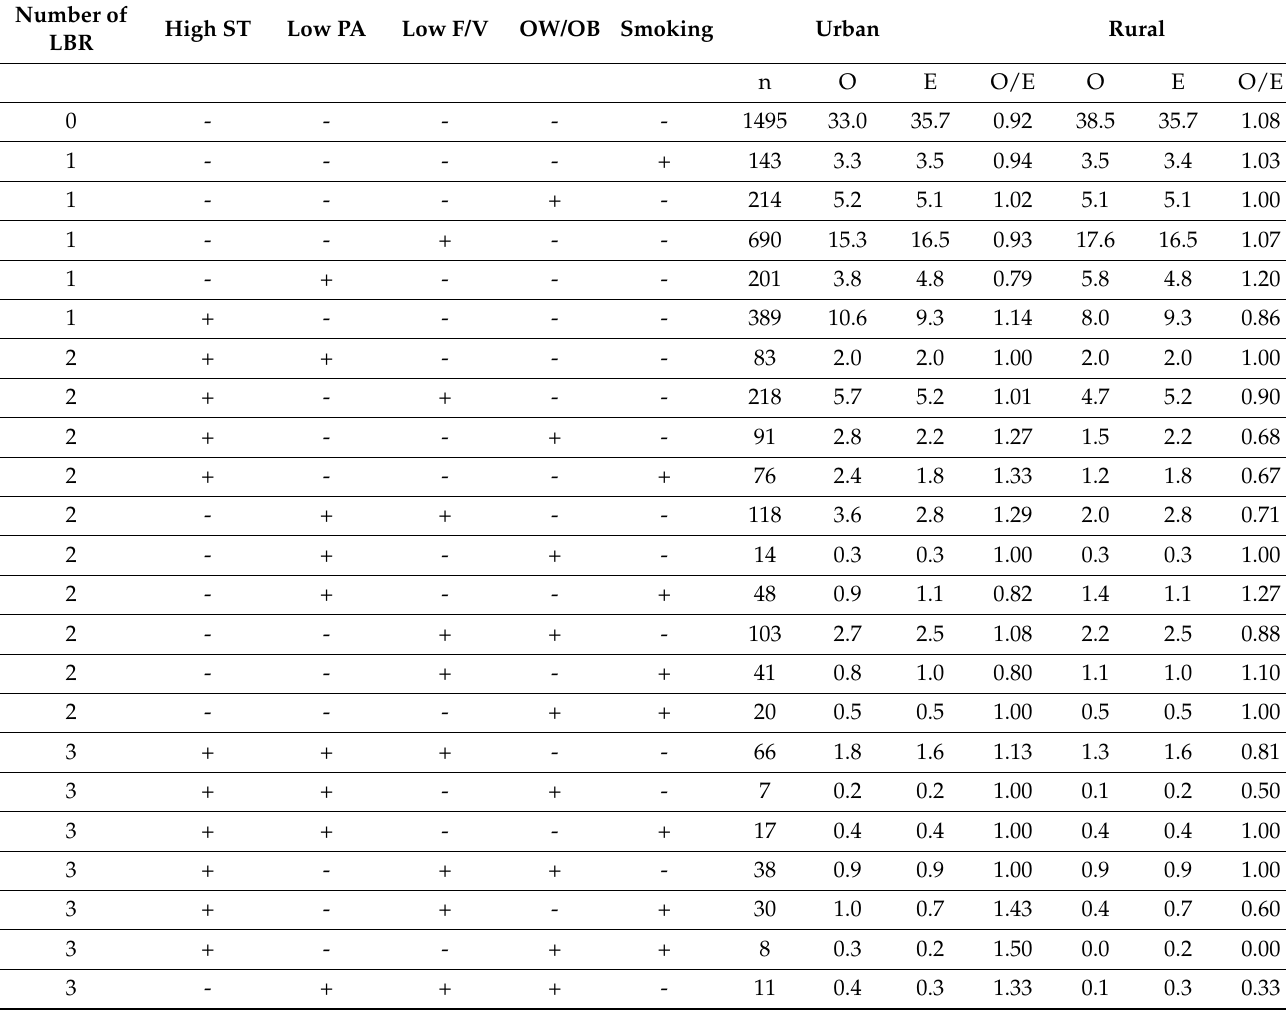
Table 3. The clustering effect of the five lifestyle risk behaviors among Algerian adolescents aged 11–16 years, Global School-based Student Health Survey, Algeria,